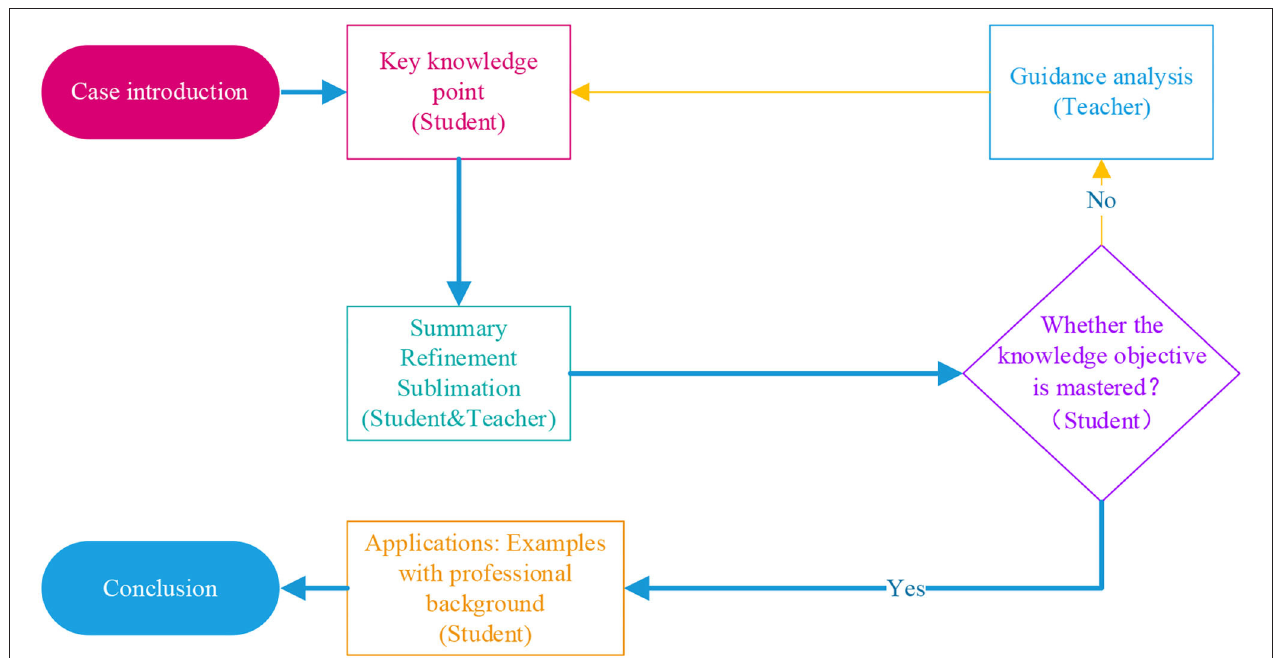
FIGURE 4 | Teaching process under an online-offline with “case study + knowledge point + applications”